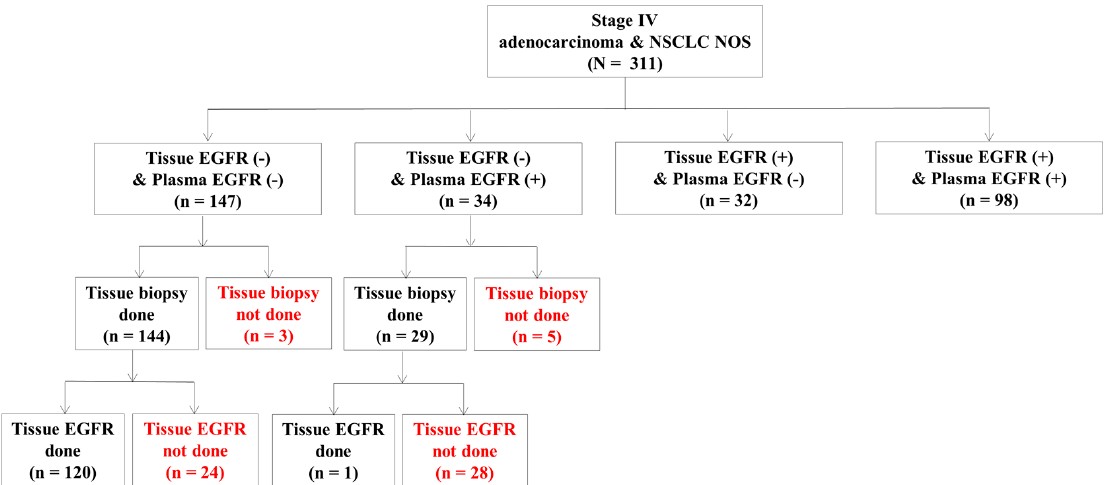
Figure 2. Groups distinguished based on the results of tissue and plasma EGFR mutation assays (positive or negative). Among 34 subjects with “Tissue EGFR ( − ) & plasma EGFR (+),” there were 5 who did not undergo tissue biopsy and 28 who underwent tissue biopsy but did not have sufficient remaining tissue specimens for EGFR mutation testing. One subject had a negative result from the tissue EGFR assay, while the plasma EGFR mutation assay was positive. NSCLC NOS, non-small cell lung cancer not otherwise specified.